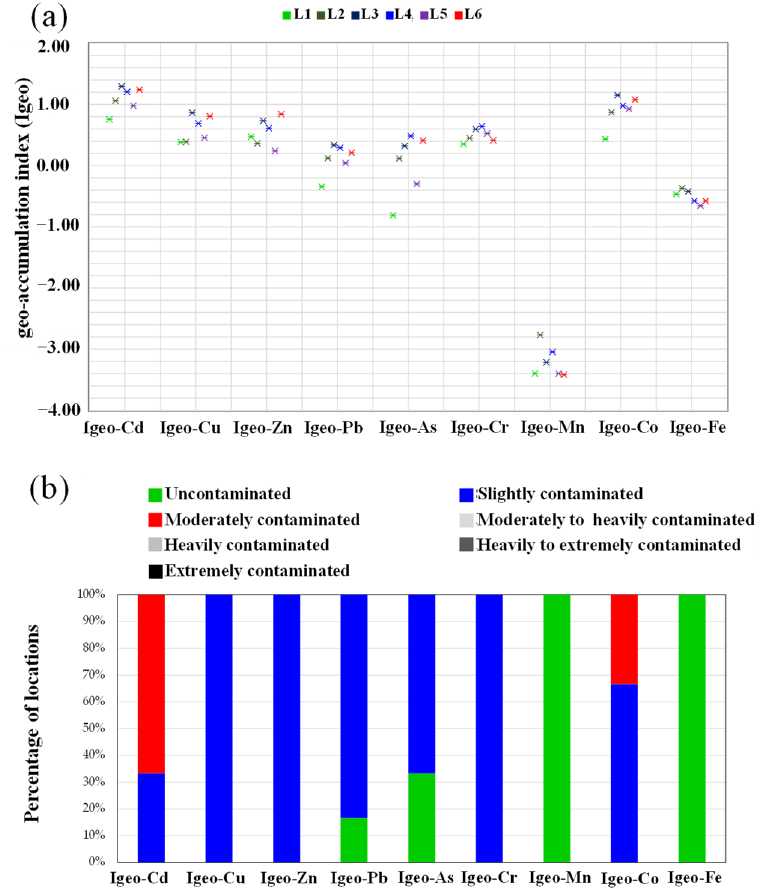
Figure 2. Results of the geoaccumulation index: ( a ) I geo values of each heavy metal in all locations and ( b ) location-based percentage I geo for each heavy metal.